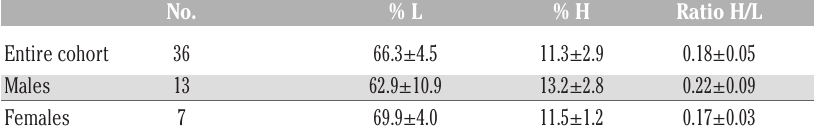
Table 1. Mean of % of lymphocytes, heterophils and H/L ratio. The results are expressed as mean ± standard deviation.